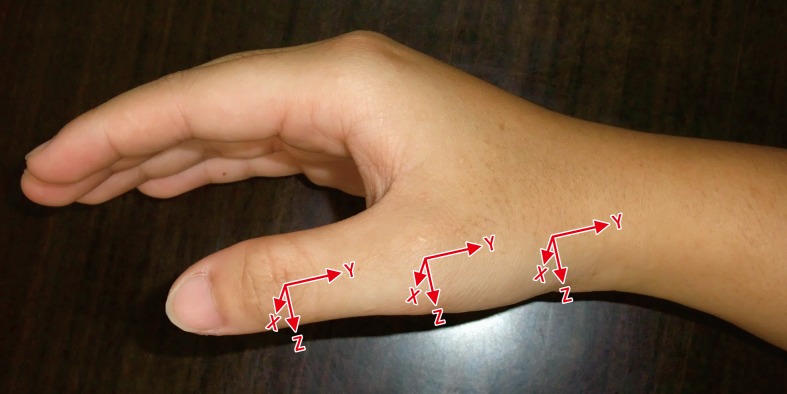
The local coordinate systems of the right thumb segments were shown.X axis = dorsal/ volar axis; Y axis = distal/proximal axis; Z axis = ulnar/radial axis